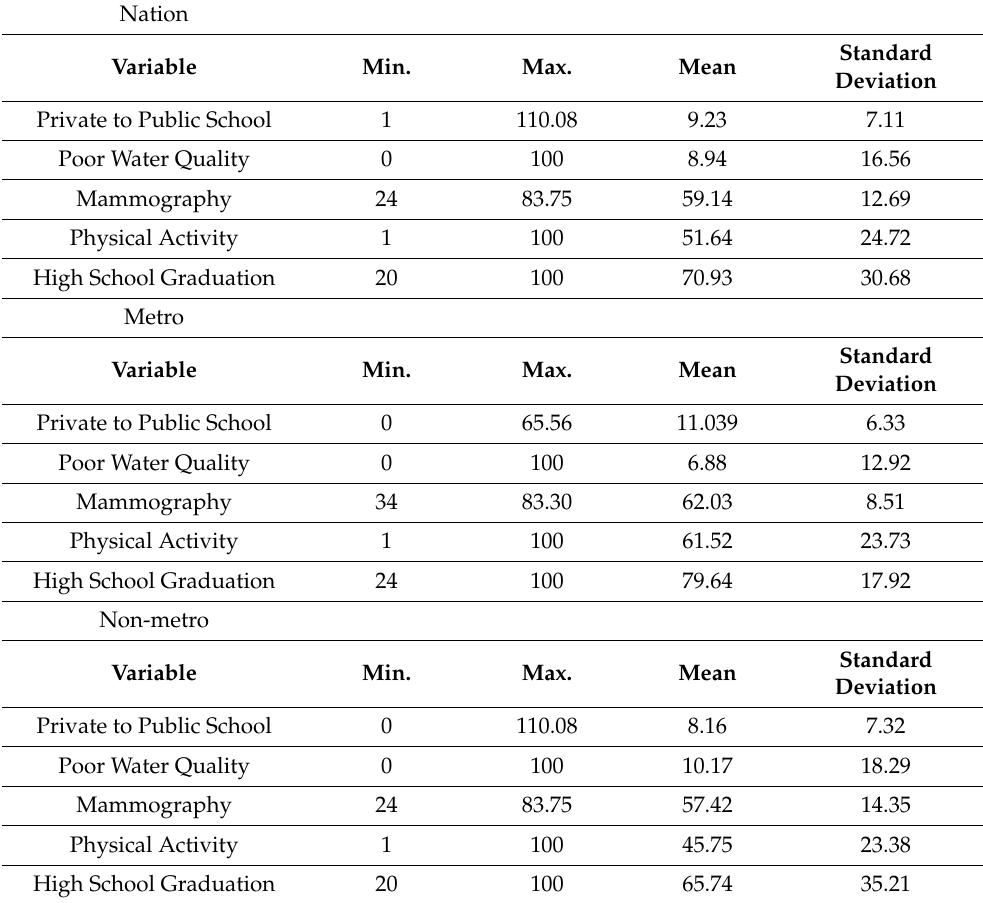
Table A5. Descriptive statistics for quality/outcomes of public services.